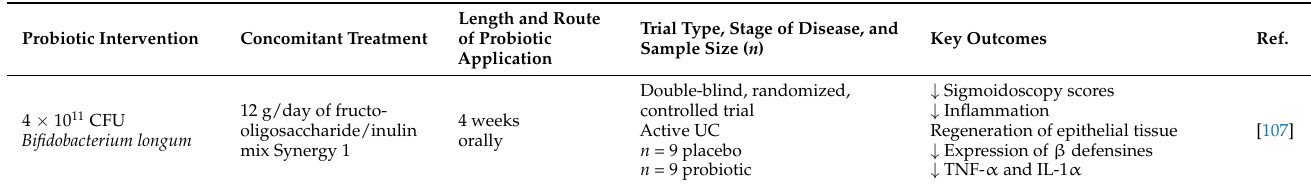
Table 1. Efficiency of probiotics with/without prebiotic in UC treatment. Probiotic